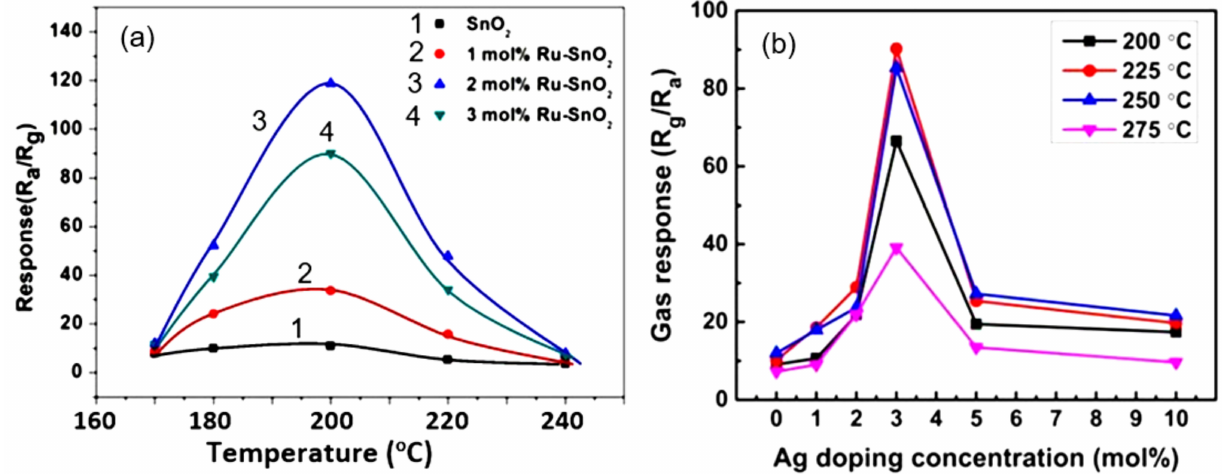
Figure 14. ( a ) Response of sensors based on pure and 1, 2 and 3 mol% Ru-doped SnO 2 nanofibers to 100 ppm acetone as a function of the operating temperature. ( b ) Influence of Ag doping on the response to 5 ppm NO 2 of electrospun WO 3 :Ag-based sensors. ( a ) Reprinted with permission from [190]. Copyright 2020: Elsevier; ( b ) Reprinted with permission from [191]. Copyright 2018